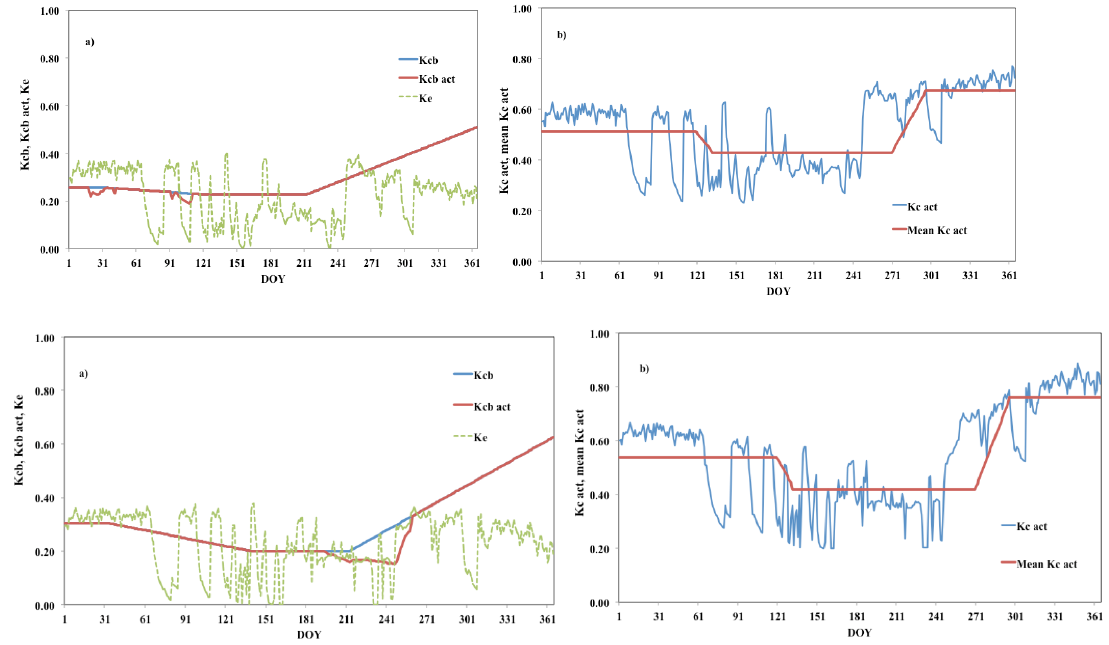
Figure 6. Daily crop coefficients derived from the SIMDualKc model in the year 2014 for 70DI (upper panel) and 50DI (lower panel); ( a ) basal crop coefficient adjusted for climate conditions and canopy density (K cb ), basal crop coefficient (K cb act ) adjusted for water stress conditions, soil evaporation coefficient (K e ); ( b ) actual (K c act ) and mean crop coefficient for the different growth stages. For 70DI, the values were 0.24 for K cb ini , 0.26 for K cb mid , and 0.43 for K cb end . A slight water stress for